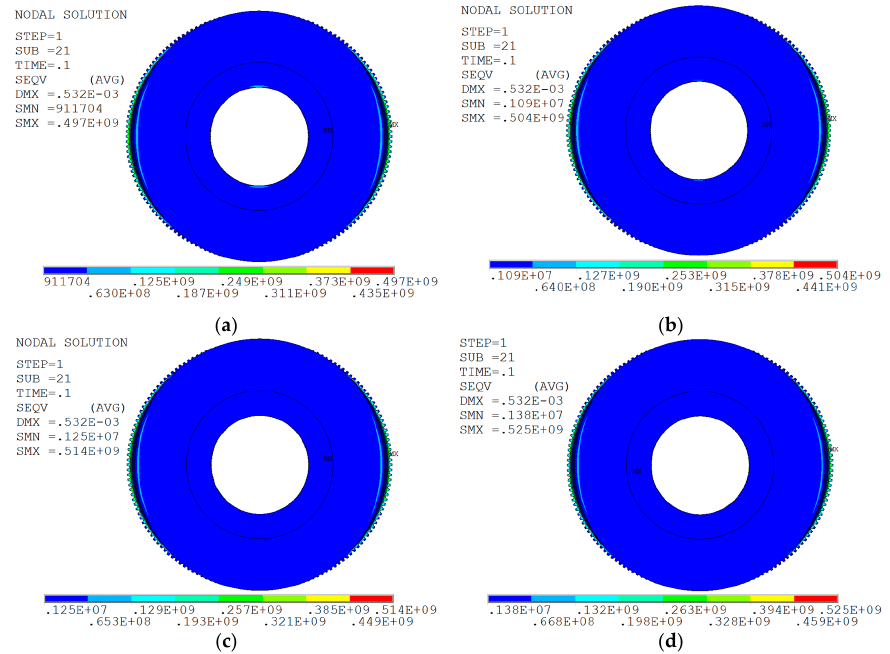
Figure 20. Flexible wheels stress cloud chart of different smooth cylinder wall thickness. ( a ) = 0.74 mm; ( b ) = 0.78 mm; ( c ) = 0.82 mm; ( d ) = 0.86 mm. It can be seen from Figure 20 that, when δ = 0.74 mm, the maximum equivalent stress value of the flexspline is 497 MPa, and when δ = 0.86 mm, the maximum equivalent stress value of flexspline is 538 MPa, which increases by 8.2%. The fitting curve of the analysis results is shown in Figure 21.